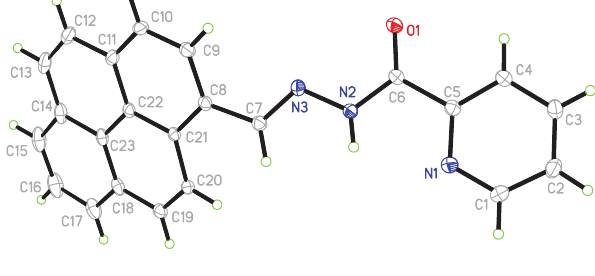
Table 1: Data collection and handling.